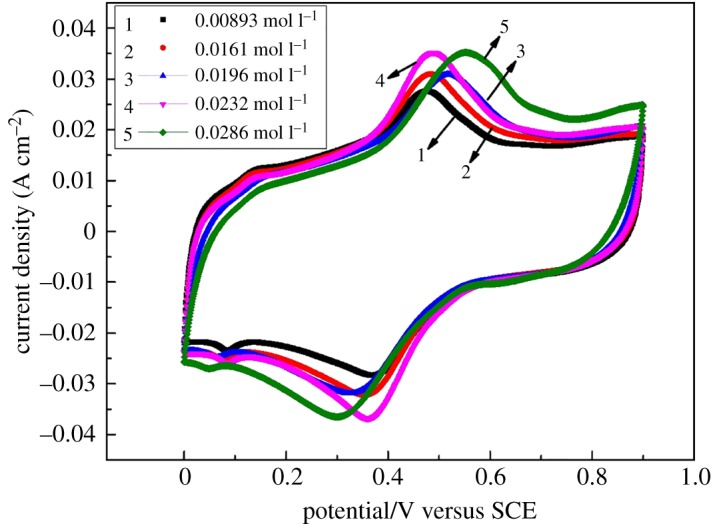
CV curves of 2.8 M H2SO4 solution with different concentrations of Fe(III) at a scan rate of 0.1 V s−1.